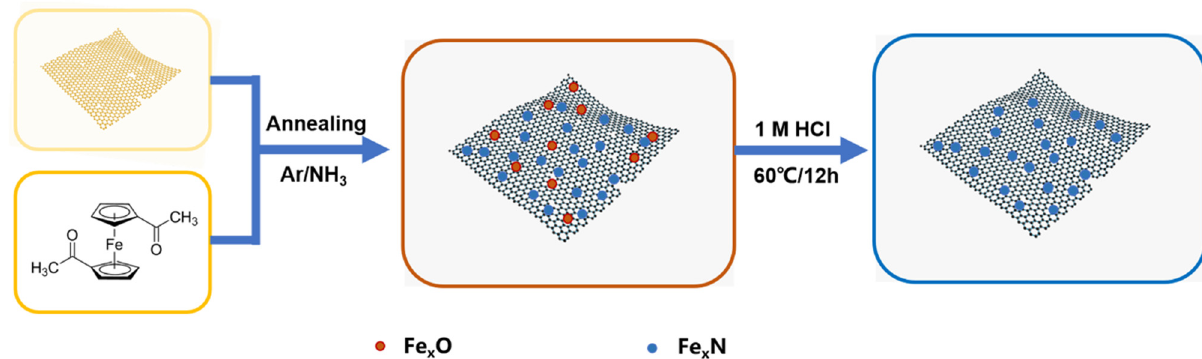
Figure 1: The schematic diagram of the synthesis process of the Fe x